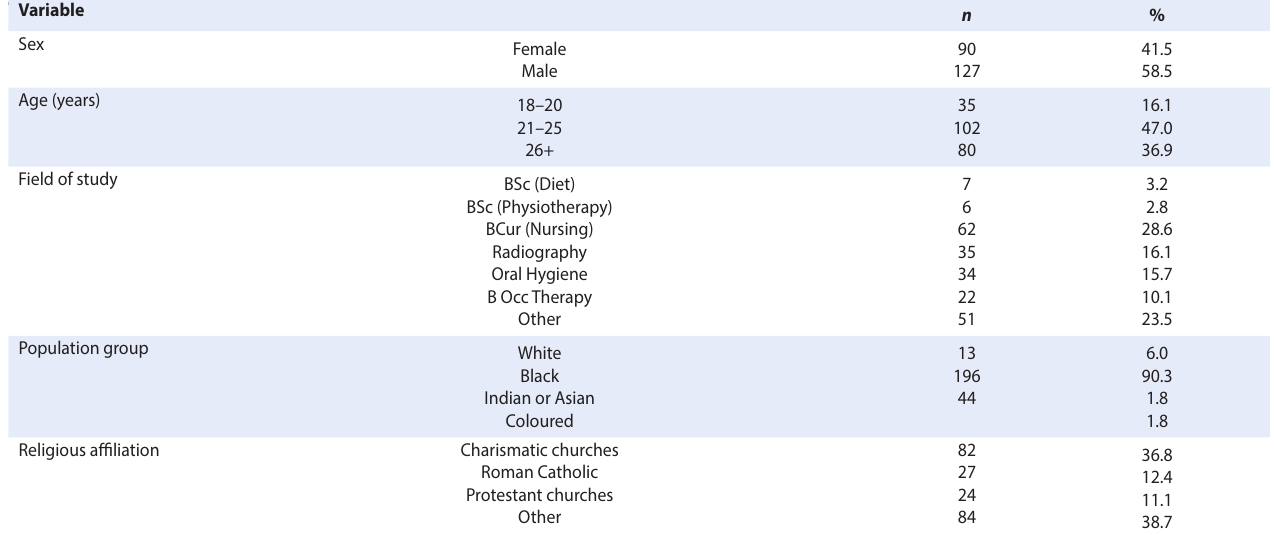
Table 1: Demographic characteristics of the participants Variable n